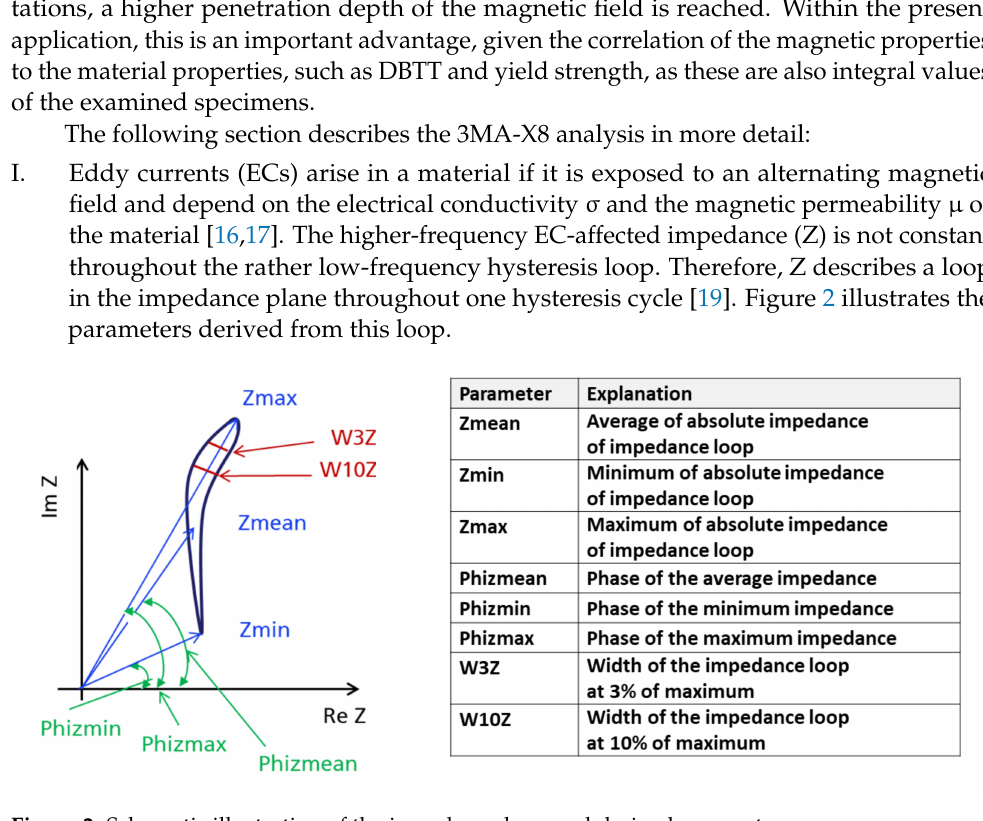
Figure 2. Schematic illustration of the impedance loop and derived parameters.